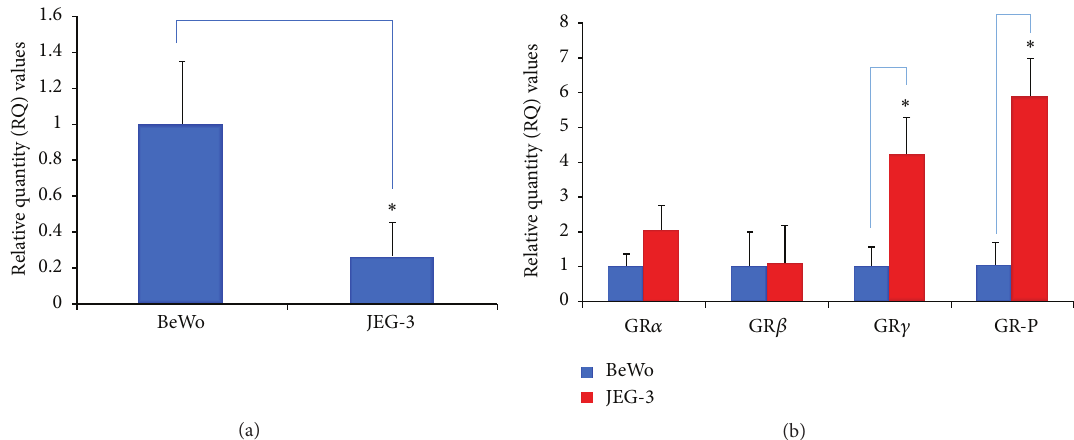
Figure 3: (a) Expression of GAS5 in BeWo and JEG-3 cells; ∗ 𝑃 < 0.05 . (b) Expression of GR 𝛼 , GR 𝛽 , GR 𝛾 , and GR-P in BeWo and JEG-3 cells; ∗ 𝑃 < 0.05 .